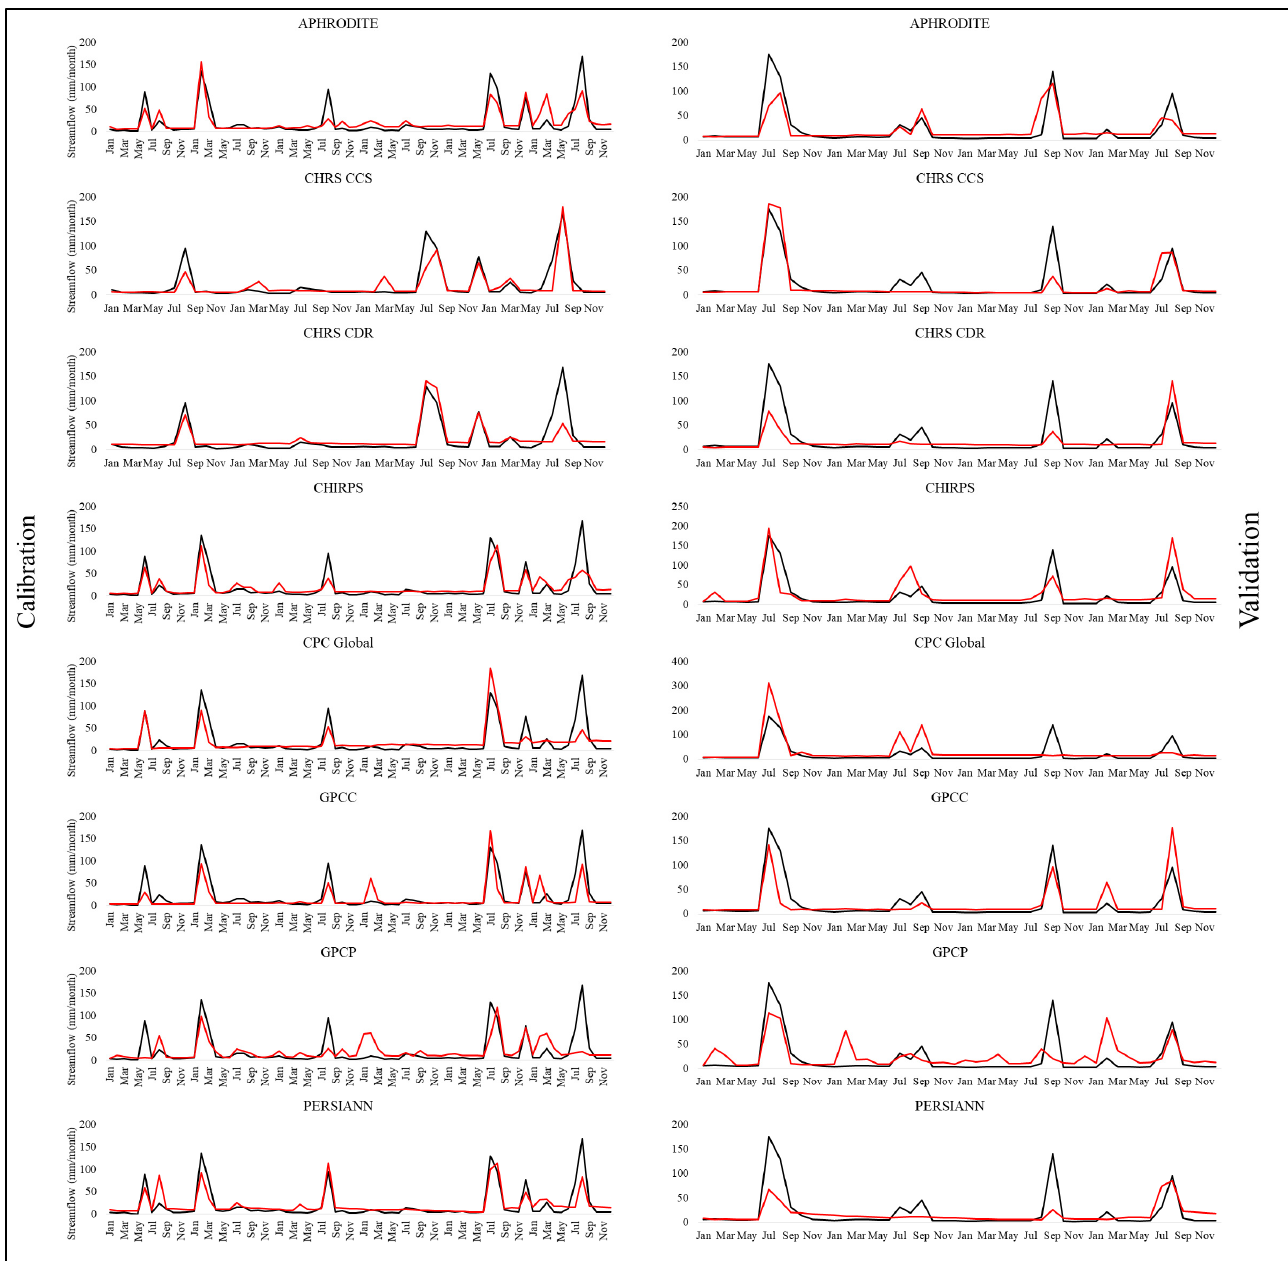
Figure 7. Monthly streamflow during calibration and validations periods simulated by the HBV-light forced with the precipitation input from eight PPs in the Dhoke Pathan sub-catchment. Table 2. Performance of eight PPs in simulating daily streamflow for Chirah and Dhoke Pathan sub- catchments.